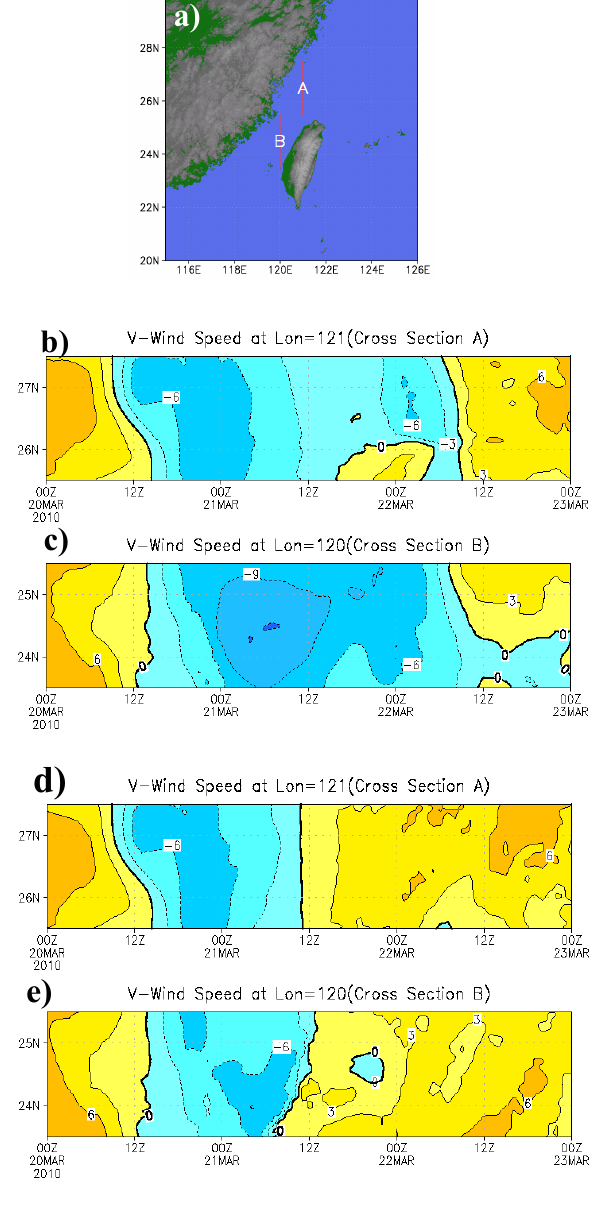
Fig. 14. (a) Schematic illustration of cross-sections A and B. (b) Temporal variation of N-S component of wind speed during 20–23 March 2010 for control run along cross A. The contour is shown in 3 ms − 1 interval. (c) Same as (b) but for along cross B. (d) Same as (b) but for Case QT along cross A. (e) Same as (b) but for case QT along cross